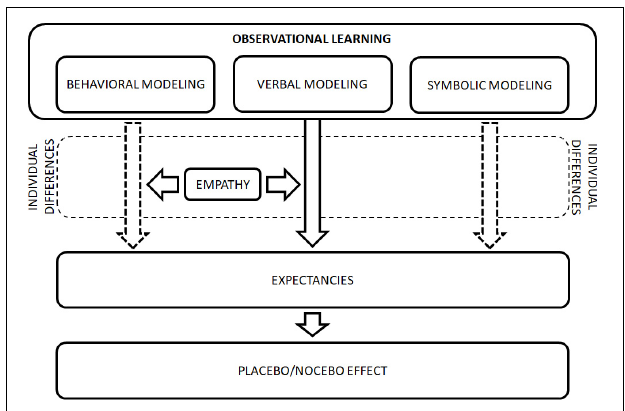
FIGURE 1 | Formation of placebo effects induced by observational learning. Figure depicts the ways of transmission of information concerning pain from the model to the observer: (1) behavioral modeling, (2) verbal modeling, and (3) symbolic modeling. The information conveyed to the observer may contribute to the formation of expectancies of analgesia/hyperalgesia and thereby induce the placebo/nocebo effect. Individual characteristics of the observer, including empathy, are also involved in the formation of observationally induced analgesia and hyperalgesia. The relationships confirmed in previous studies are drawn with a solid line, while those which seem to be possible but are not yet confirmed are depicted with a dashed